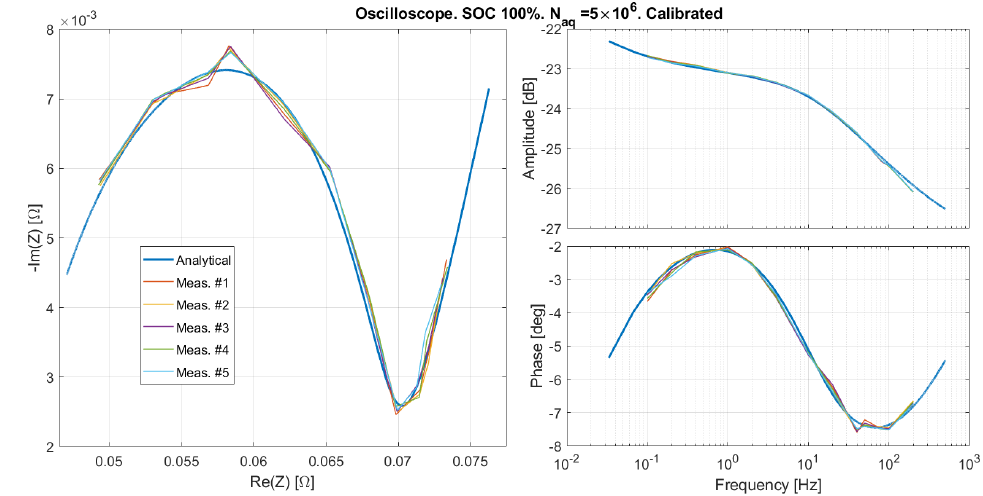
Figure 14. The emulated impedance as measured by means of a bench oscilloscope after the calibra- tion illustrated in Section 5.1.